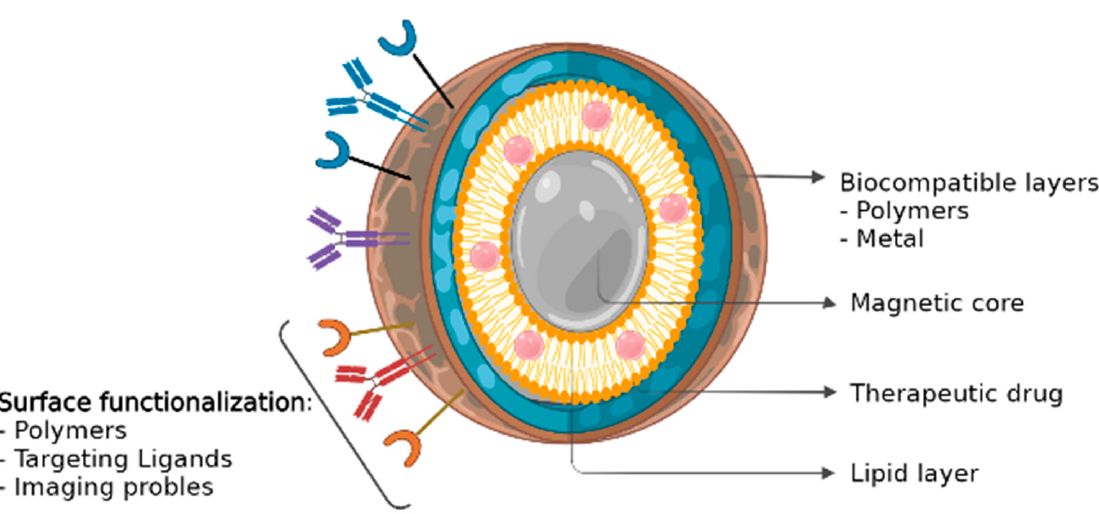
Figure 2. Magnetic nanoparticle (MNP) structure. MNPs are usually constituted by a magnetic core–shell encapsulated by a biocompatible coating [42], where chemotherapeutics are loaded